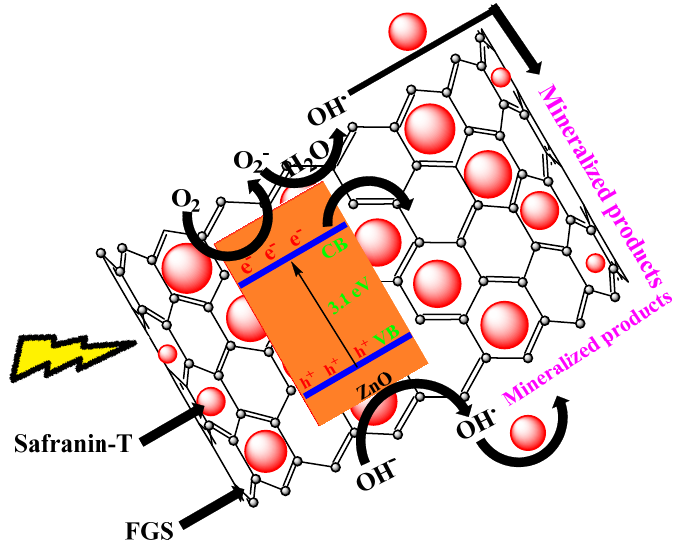
Figure 17. Illustration of the degradation of safranin-T dye by FGS/ZnO materials